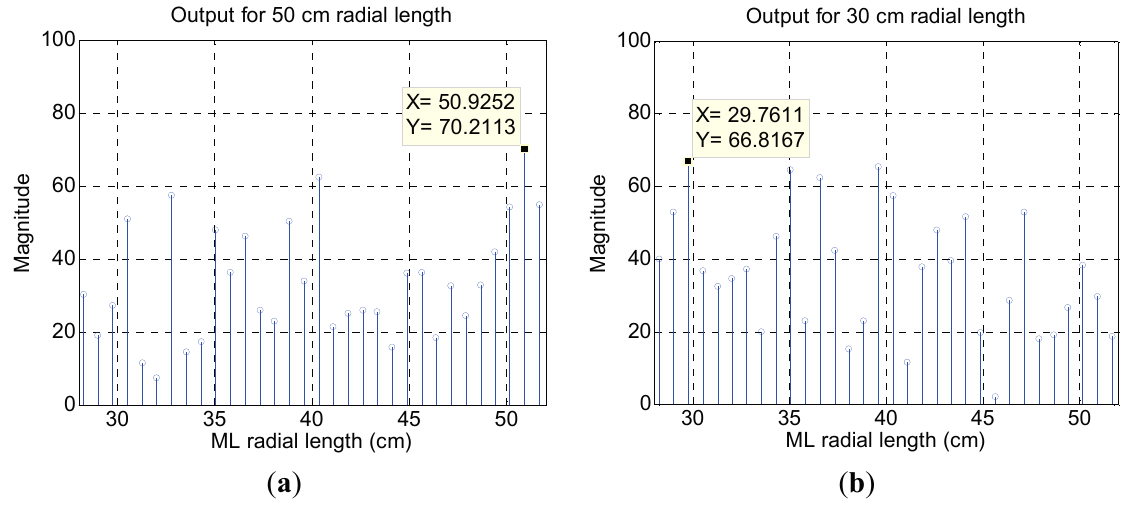
Figure 12. ML algorithm output ( a ) for 50 cm radial length; and ( b ) for 30 cm radial length of ML